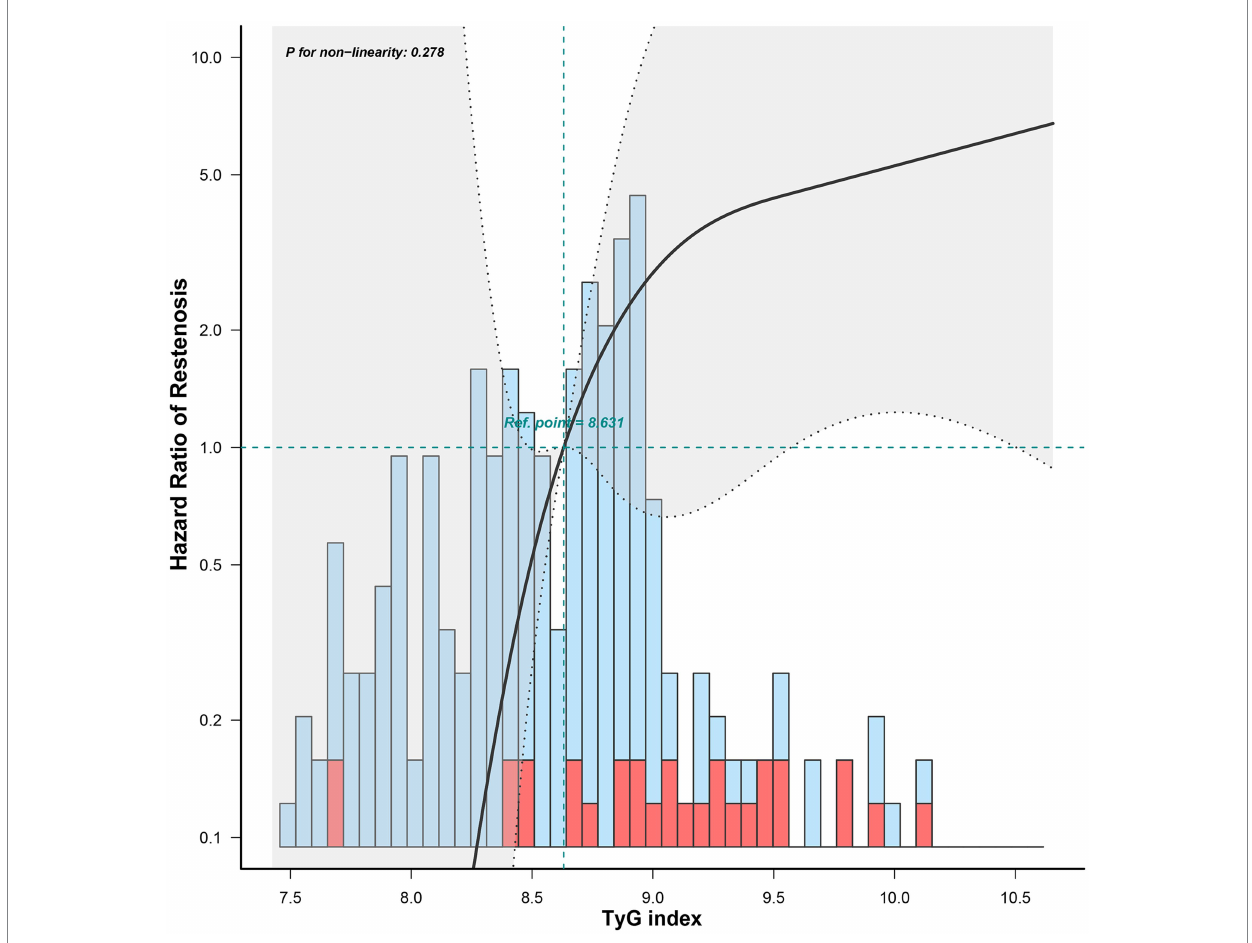
FIGURE 5 The dose–response relationship of the preoperative TyG index with restenosis.